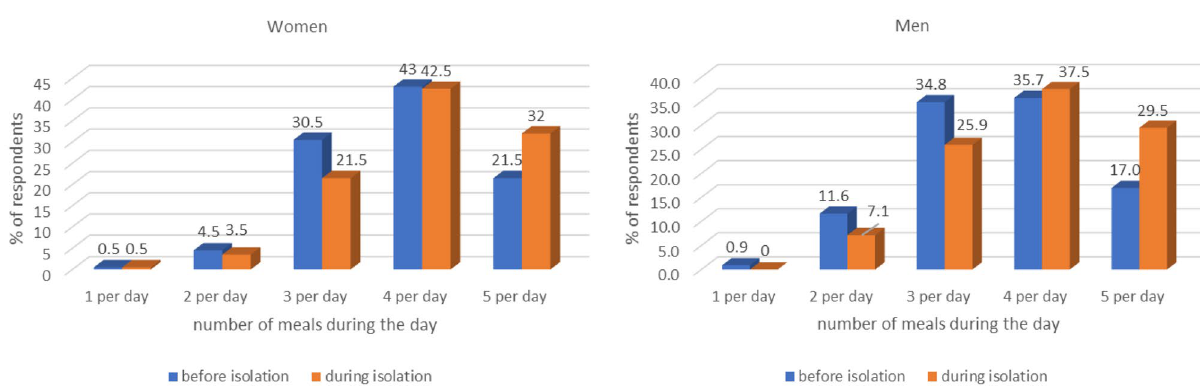
Figure 2. Number of meals consumed during the day.